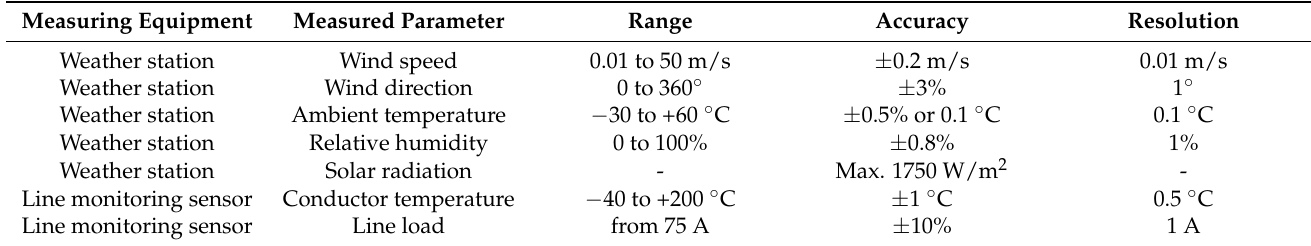
Table 2. Technical parameters of weather stations and line monitoring